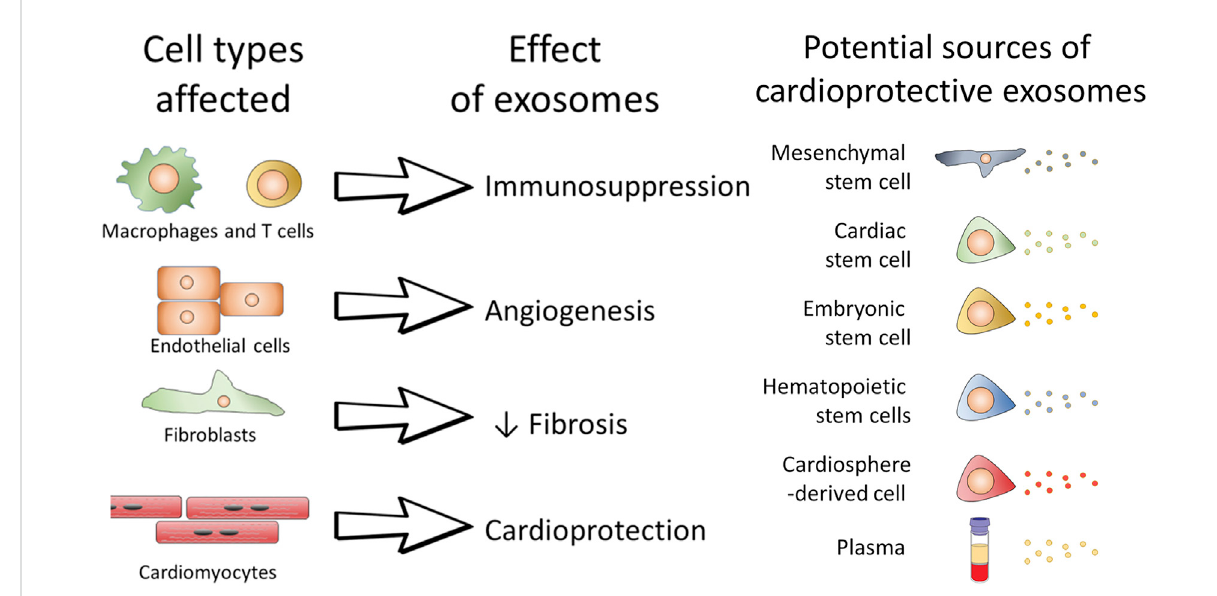
FIGURE 4 The role of exosomes on individual cells and the possible potential therapeutic role of exosomes.(Davidson & Yellon,